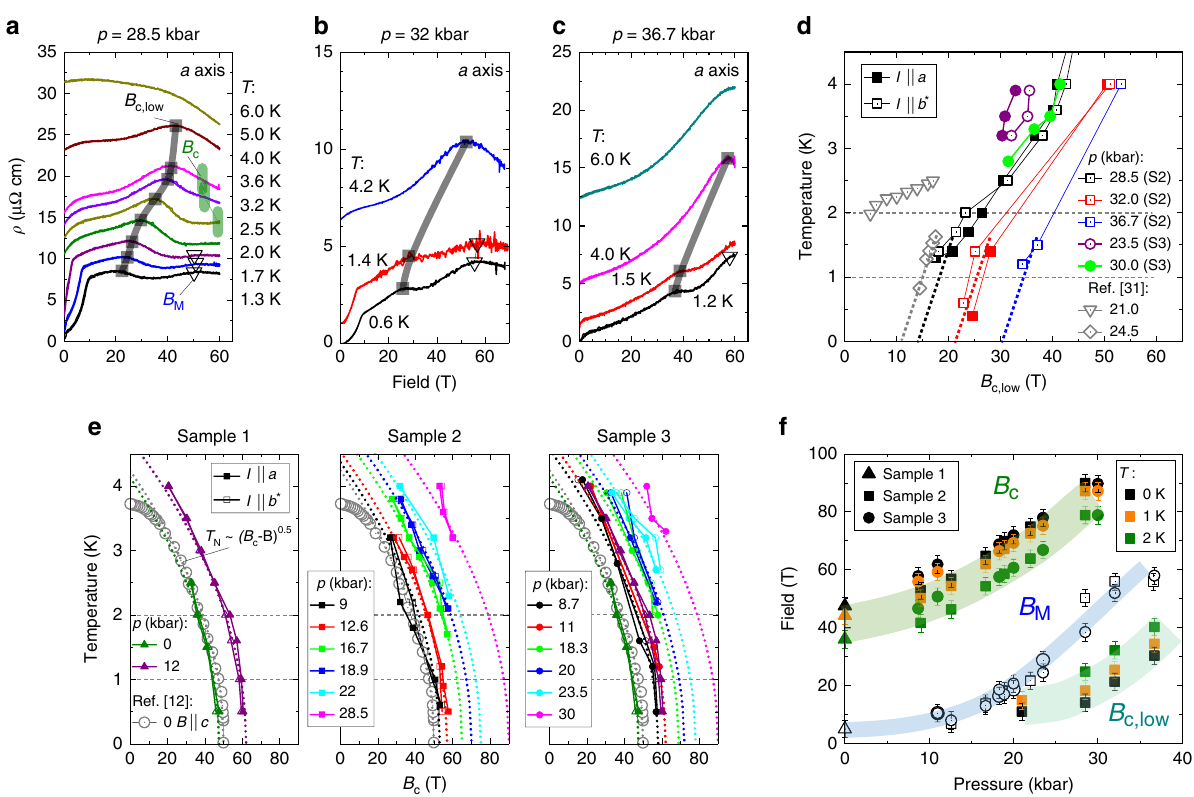
Fig. 6 Signatures of fi eld-induced magnetic order. a – c MR recorded at various temperatures for sample 2 at pressures 28.5, 32, and 36.7 kbar with I ∣∣ a - axis ( I ∣∣ b * -data are given in Supplementary Figs. 5 – 10). Black squares mark the critical fi eld B c,low we associate with fi eld-induced magnetic order, shifting to higher fi eld as temperature increases. Green vertical dashes indicate the slope change related to B c . Hollow triangles mark the low temperature feature related to the metamagnetic transition fi eld B M . Note: we determined all points from 2nd derivatives, see Supplementary Figs. 6 – 10. d Pressure dependence of B c,low . Gray data points are from previous resistivity measurements by ref. 31 . e Temperature dependence of B c ( p ). Gray circles are speci fi c heat data for B ∥ c from Ref. 12 . Dashed lines are fi ts to T ∝ ( Bc − B ) 0.5 , see text. f Extrapolated critical fi elds B B B N c , c,low , and M at 2, 1, and 0 K plotted versus